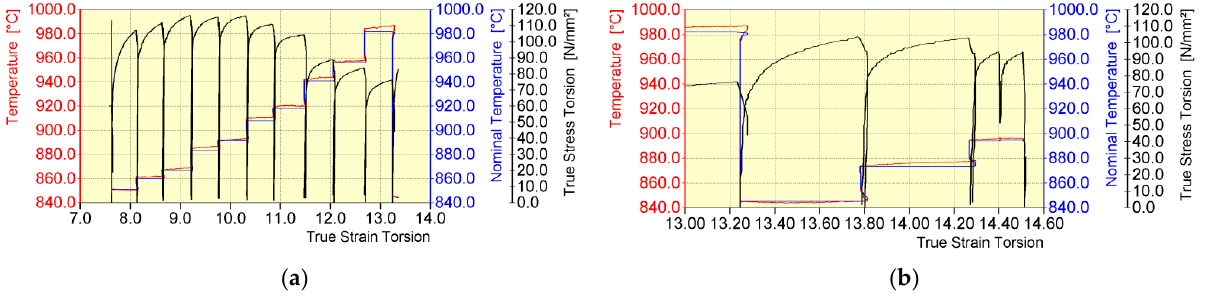
Figure 9. General course of temperature (nominal and obtained) and yield stress during physical modelling of rolling a 20MnB4 steel wire rod with a diameter of 5.5 mm (test variant V1): ( a ) in an NTM block and ( b ) in an RSM block.